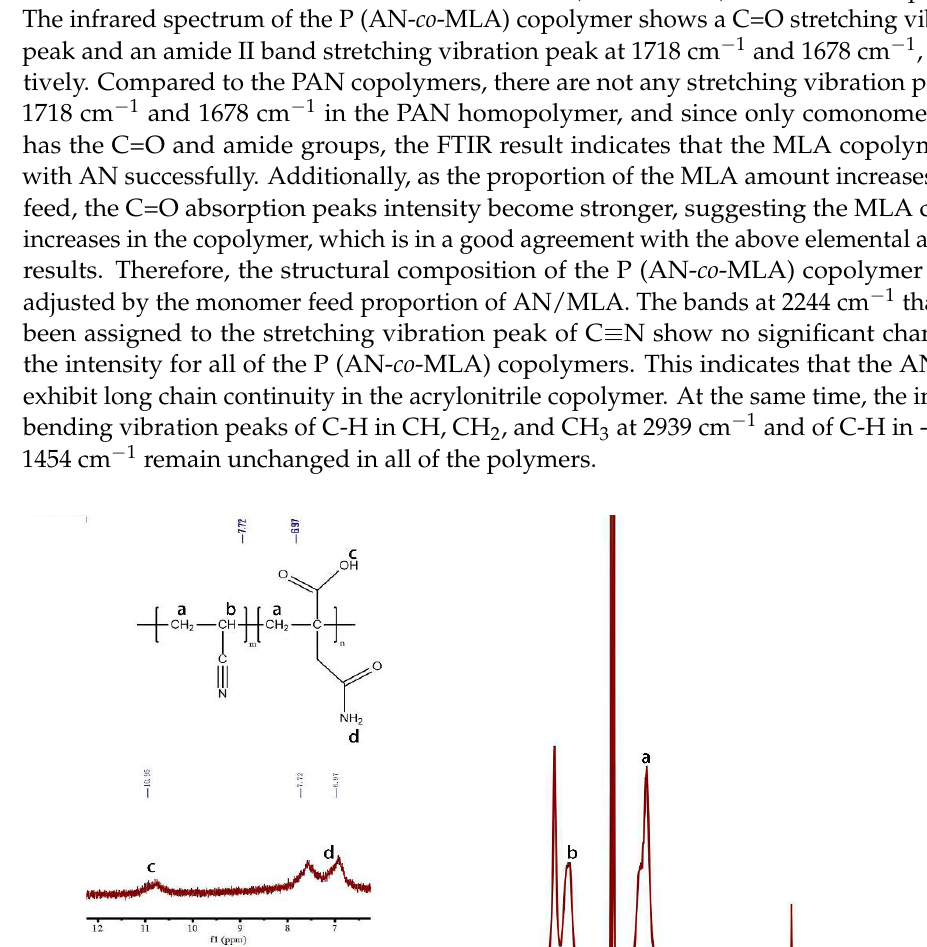
Figure 3. The results of P (AN- co -MLA) copolymers with various mass feed monomer ratios through elemental analysis.